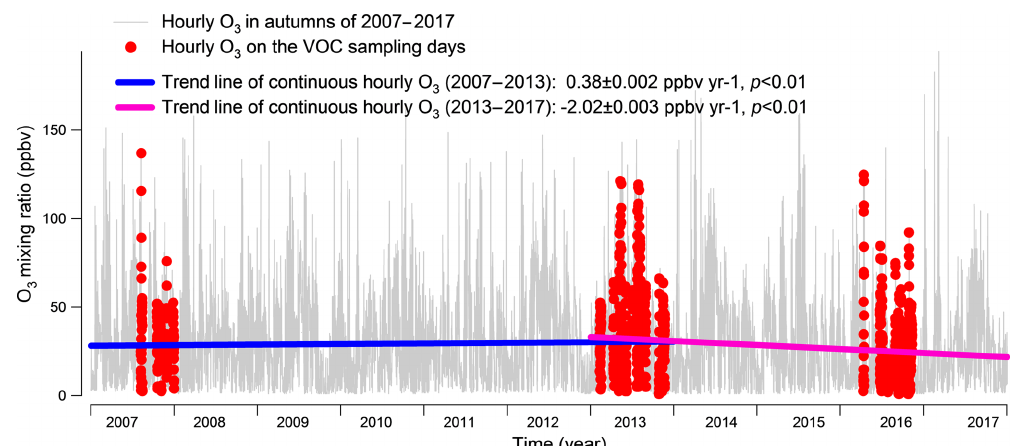
Figure 2. Long-term trends of the observed O 3 at TC from 2007 to 2017. Hourly O 3 values on the VOC sampling days in the autumns of 2007, 2013 and 2016 are marked in red. The hourly variation rates of O 3 are converted to yearly rates in the periods of 2007–2013 and